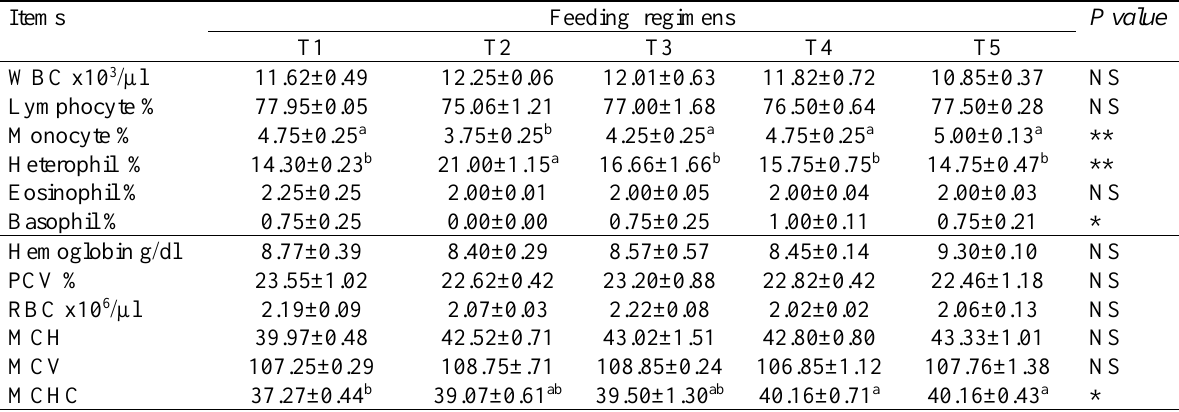
a, b, = Mean values within rows with different superscripts letters are significantly different.* ( p<0.05 ), ** ( p<0.01 ) NS non